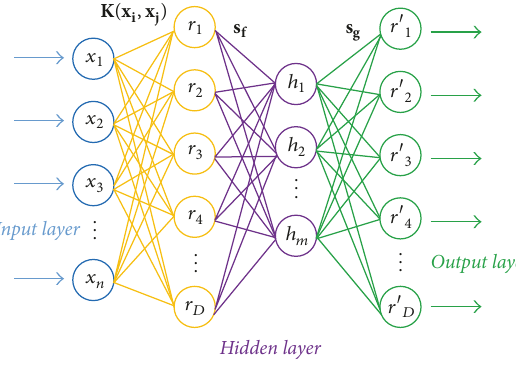
Figure 1: The structure of